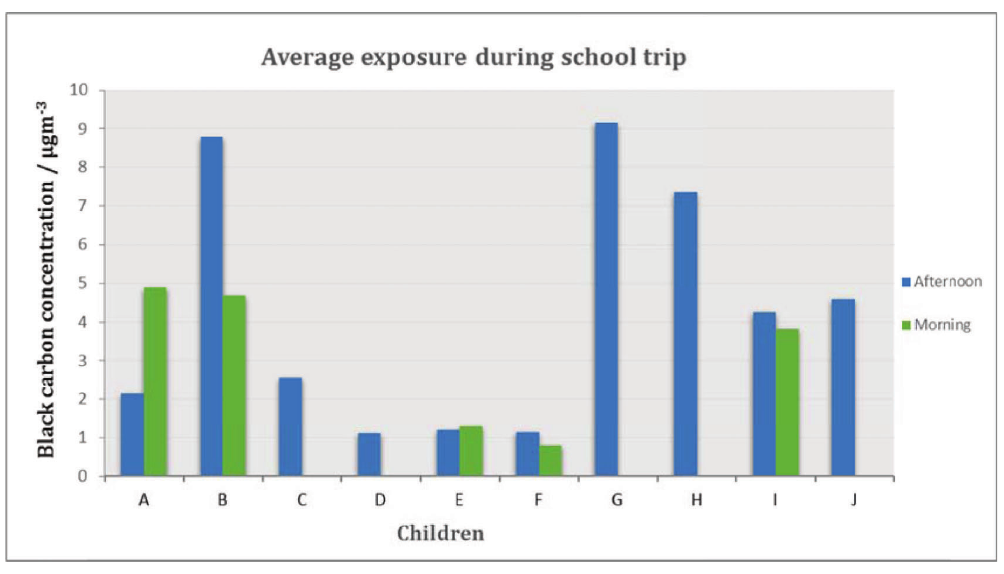
Figure 3: Average black carbon concentration during school